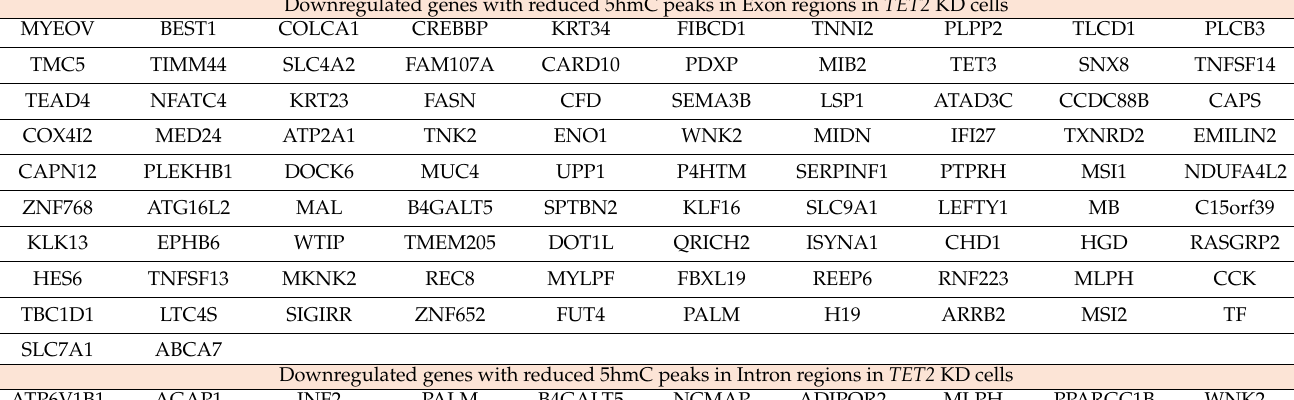
Table 1. Downregulated genes with reduced 5hmC levels in TET2 knockdown